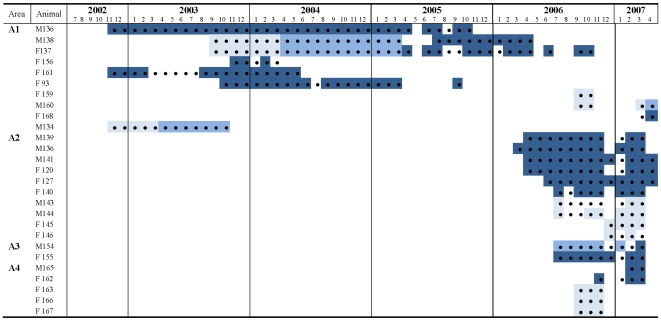
Monitoring of individual lynx in four areas (A1–A4) with feeding stations (FS) within the Doñana region.Blue-shading indicates age class: juvenile (light), subadult (intermediate), and adult (dark). The first blue-shaded cell represents the month when the individual was first detected in a FS. The last blue-shaded cell indicates the month when the lynx died or abandoned the area, or when our study ended (April 2007). Black dots represent camera operation inside FS. Two adult males, one in A1and A4, that were detected only once are not shown.